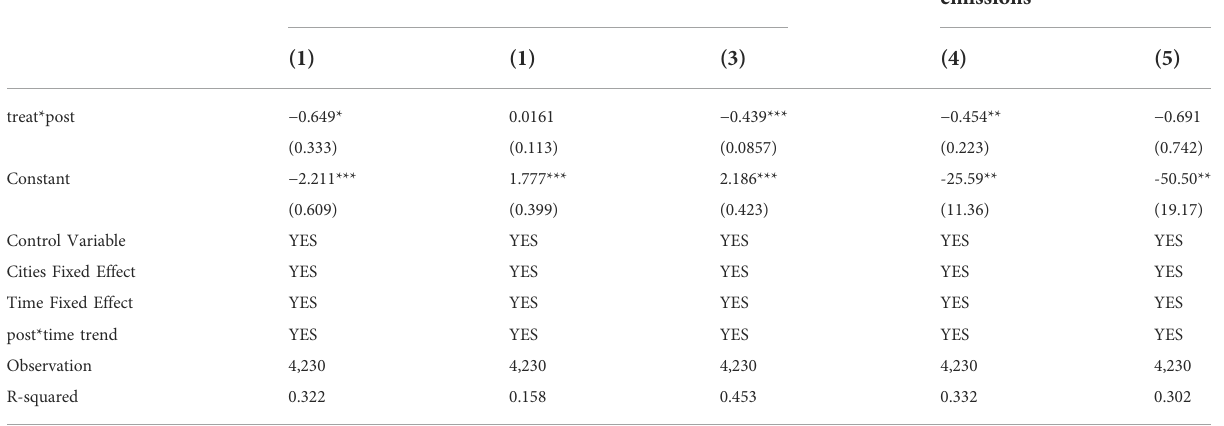
TABLE 9 Heterogeneity